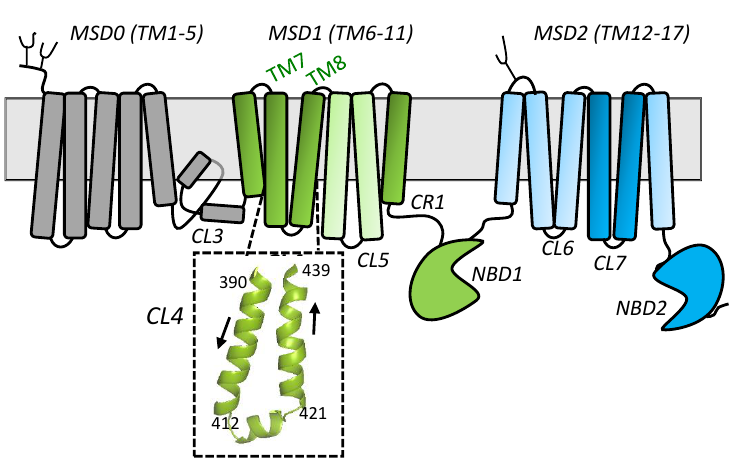
Figure 1. Schematic diagram of the secondary structure of human MRP1 highlighting CL4. Shown is a linear 2-dimensional illustration of the domain structure of MRP1/ABCC1. MSD0 (TM 1-5) (gray) is present only in a subset of 8 ABCC/MRP subfamily members and is connected to MSD1 (TM 6-11) by cytoplasmic loop (CL) 3 (also often referred to as L 0 ). The MRP1/ABCC1 core structure is comprised of MSD1/NBD1 (green), and MSD2/NBD2 (blue). In its native 3-dimensional state, the 12 TM of MSD1 and MSD2 are assembled into 2 helical bundles: helix bundle 1 consisting of TM 6, 7, 8, 11, 15, 16 (dark green/blue) and helix bundle 2 consisting of TM 9, 10, 12, 13, 14, 17 (light green/blue). CL4 links TM7 to TM8 in MSD1 and is enlarged to show its 3-dimensional structure based on an atomic homology model of the hMRP1 core structure generated using the cryogenic electron microscopic (cryo-EM) structure of apo bovine Mrp1/Abcc1 (bMrp1/Abcc1) (PDB: 5UJ9) as template [14]. CL, cytoplasmic loop; CR1, connecting region 1; MSD, membrane spanning domain; NBD, nucleotide binding domain; TM,